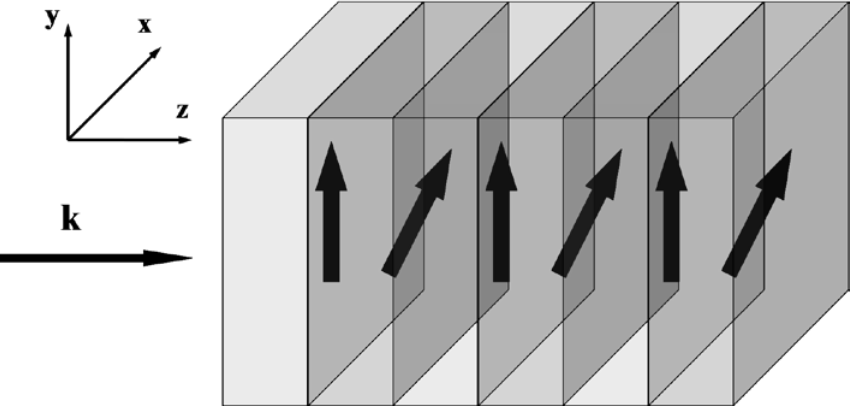
Figure 1. One-dimensional stratified PC with layers made of uniaxial materials. Thick arrows indicate orientations of the optical axes of the layers (in the plane of the layers). The left arrow k is the wave vector of an incident wave.